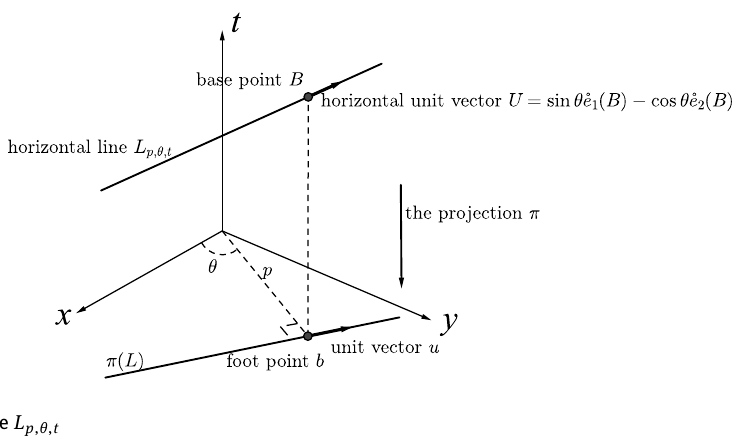
Figure 2: horizontal line L p , θ ,